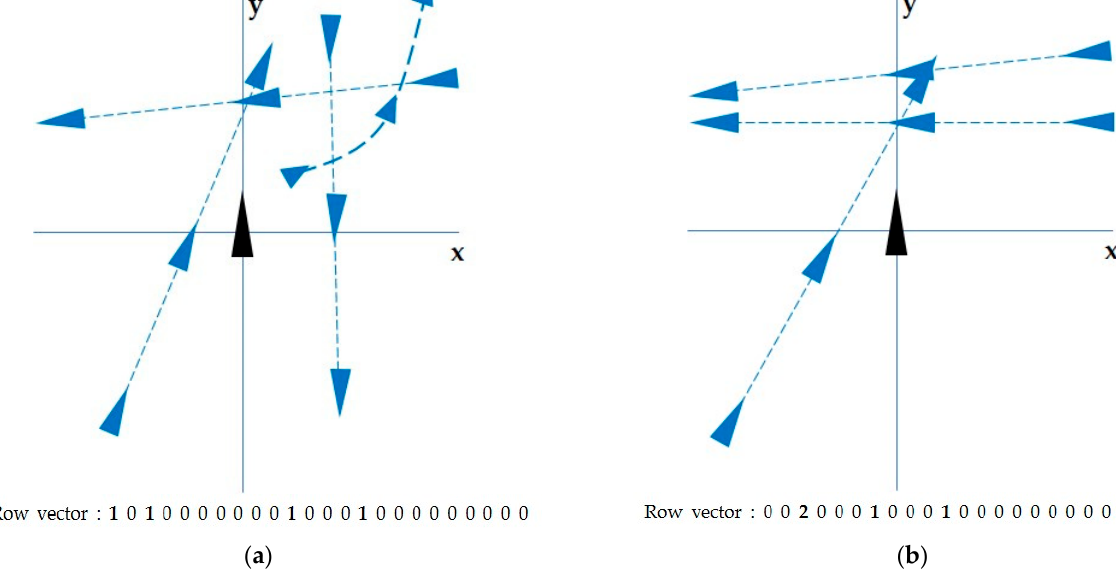
Figure 7. Example of input data: ( a ) a combined navigation situation consisting of navigation situations corresponding to features 1, 3, 11, and 15, and an example of conversion to a row vector, ( b ) a combined navigation situation consisting of navigation situations corresponding to features 3, 7, and 11, and an example of conversion to a row vector.